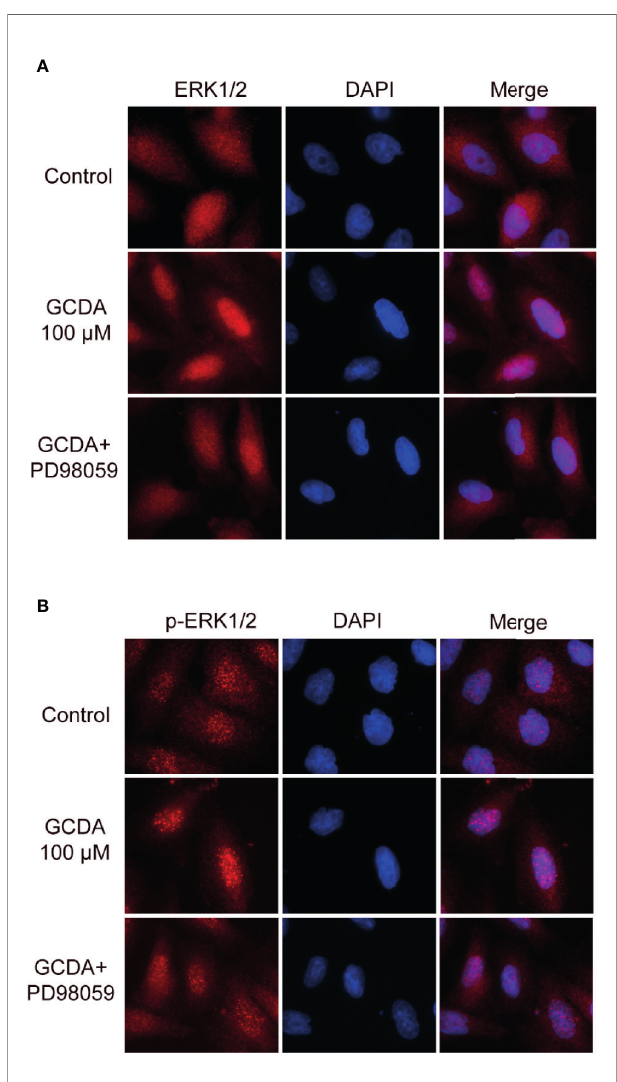
FIGURE 4 | PD98059 suppresses GCDA-induced nuclear aggregation of ERK1/2 and p-ERK1/2. (A, B) QGY-7703 cells were preincubated with PD98059 (10 m M) for 0.5 h, followed by treatment with 100 m M GCDA for 8h. Immuno fl uorescence staining was done using ERK1/2 or p-ERK1/2 antibody. Cell nuclei were stained with DAPI for 2 min. The experiments were repeated three